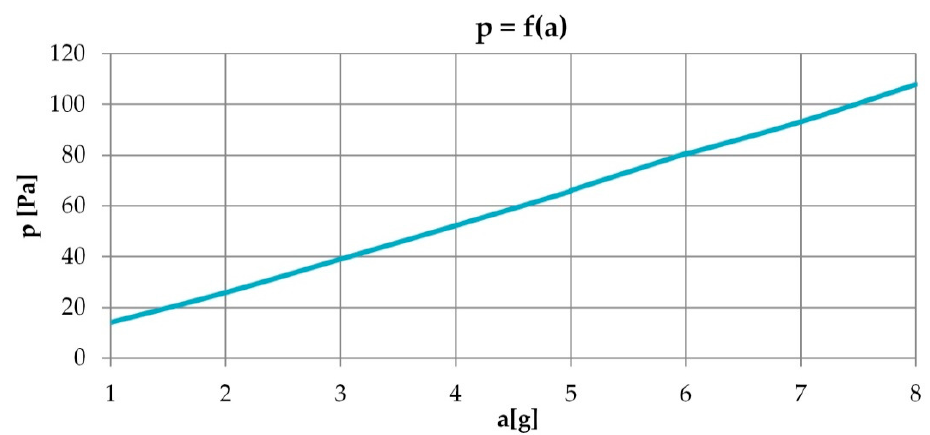
Figure 3. Dependency chart of the output signal from the sensor (RMS) depending on the acceleration, for a pressure difference equal to zero